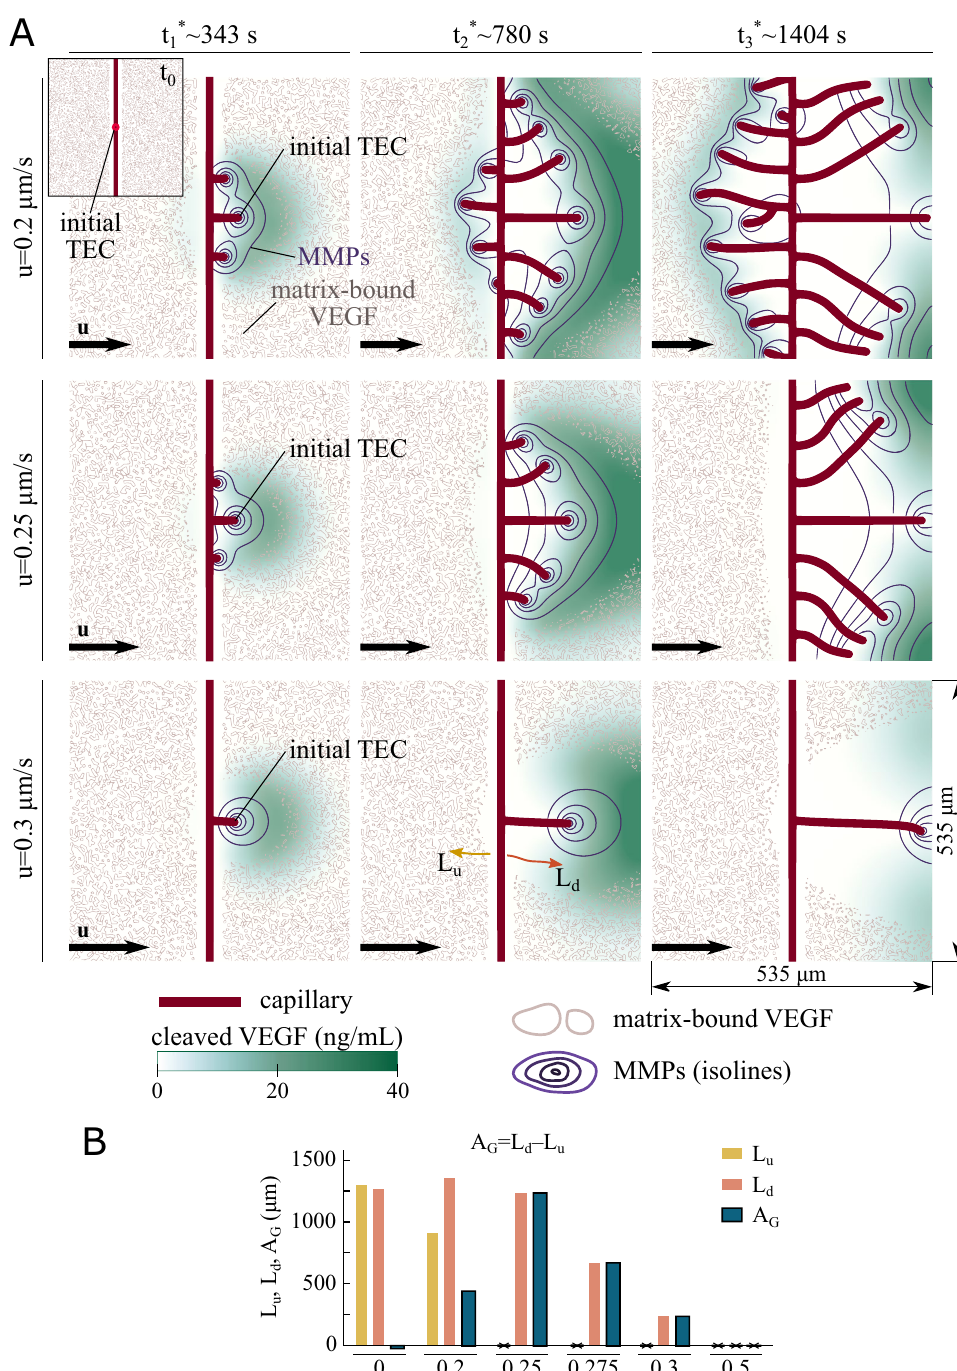
Figure 2. Flow-mediated angiogenesis controlled by matrix-bound chemokines. (A) Time evolution of the vascular network (red), cleaved-VEGF distribution (green), MMPs isolines (purple), and contour lines of the matrix-bound VEGF clusters (gray) for interstitial flow u = 0.2 (top row), 0.25 (center row), and 0.3 µ m s (bottom row). The flow is uniform from left to right. The top-left inset shows the initial configuration. Note ∗ i = 1 , 2, or 3) do not correspond to the same time, but similar times. that the plots identified as t i (where (B) Asymmetric growth ( A G ) as a function of u . L u and L d are the total length of the neovasculature growing ∗ upstream and downstream, respectively, at t 3